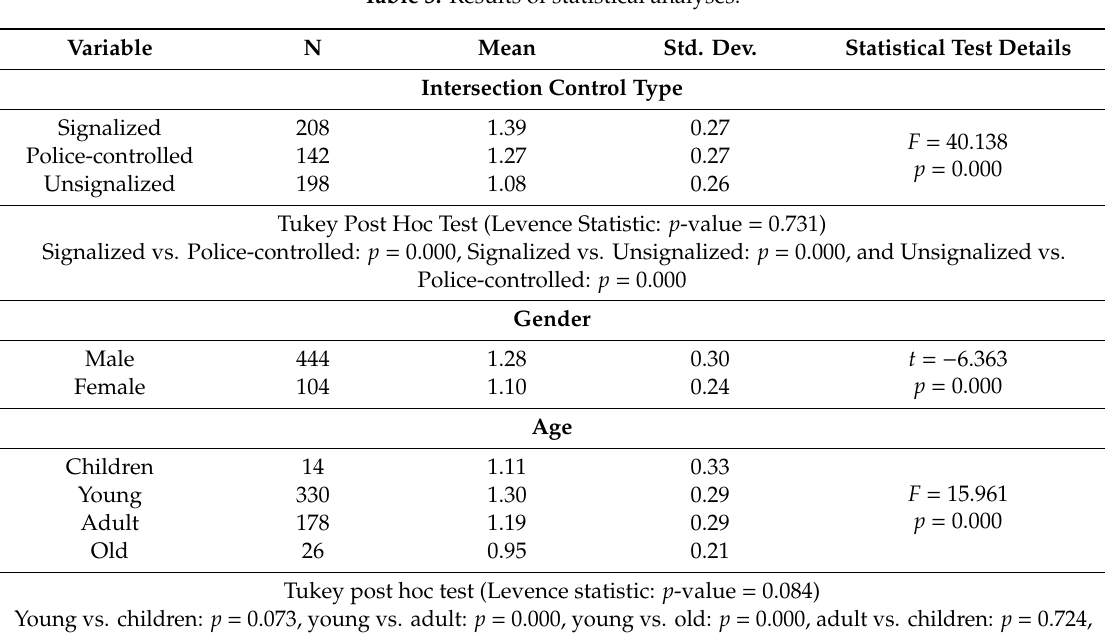
Table 3. Results of statistical